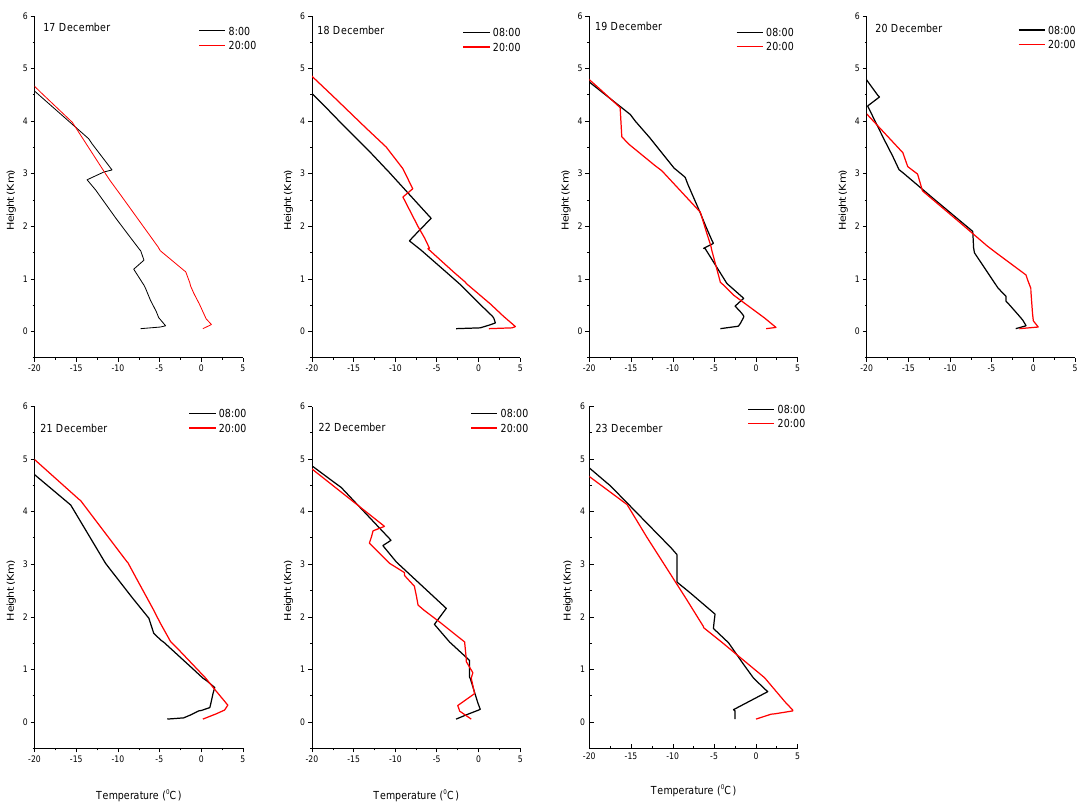
Figure 4. Vertical distribution of temperature from 17 to 23 December 2015 in Beijing (radiosonde dataset).